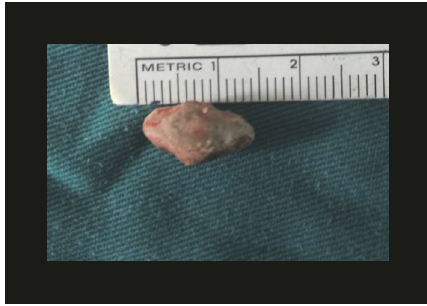
Figure 14: Stone removed (case